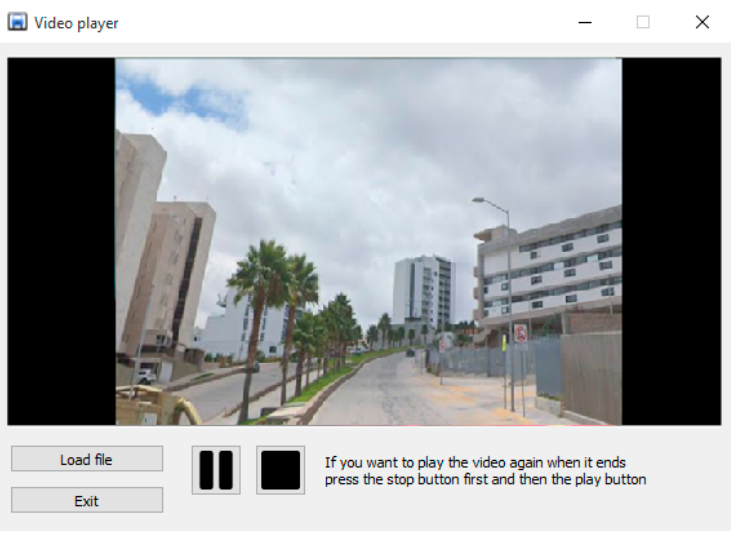
Figure 11. A screenshot of the video player.